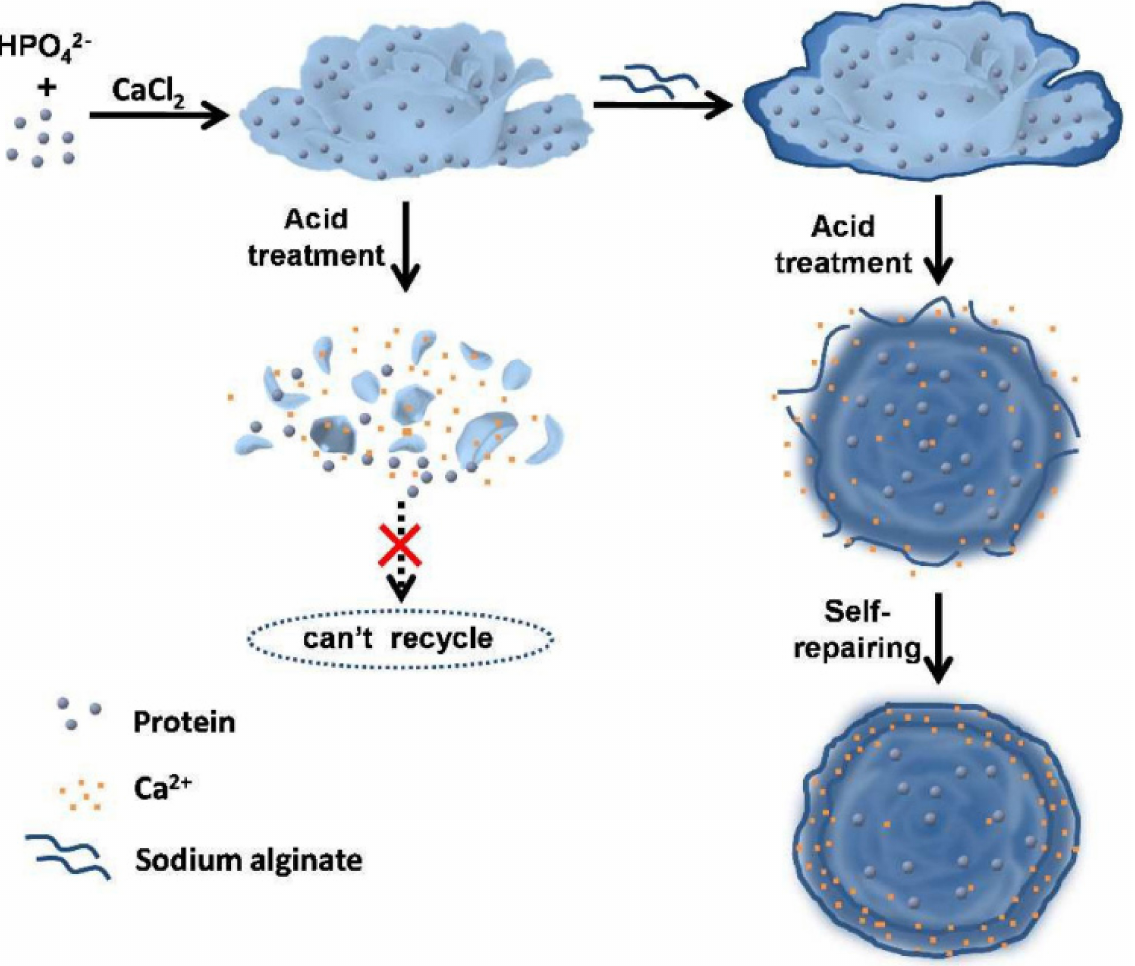
Figure 13. The process of self-repairing sodium alginate (SA)-coated CPO-Ca 3 (PO 4 ) 2 hybrid nanoflowers. Reprinted from [87] with permission from the Royal Society of Chemistry. Copyright © The Royal Society of Chemistry. License Number: